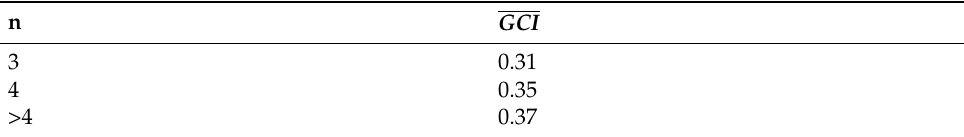
Table 3. Geometric consistency index values for different n values.